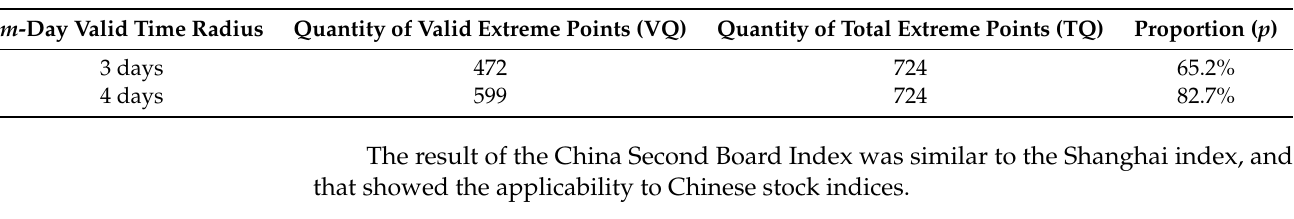
Table 4. Proportion of valid 5-day extreme points of the Shanghai Index.